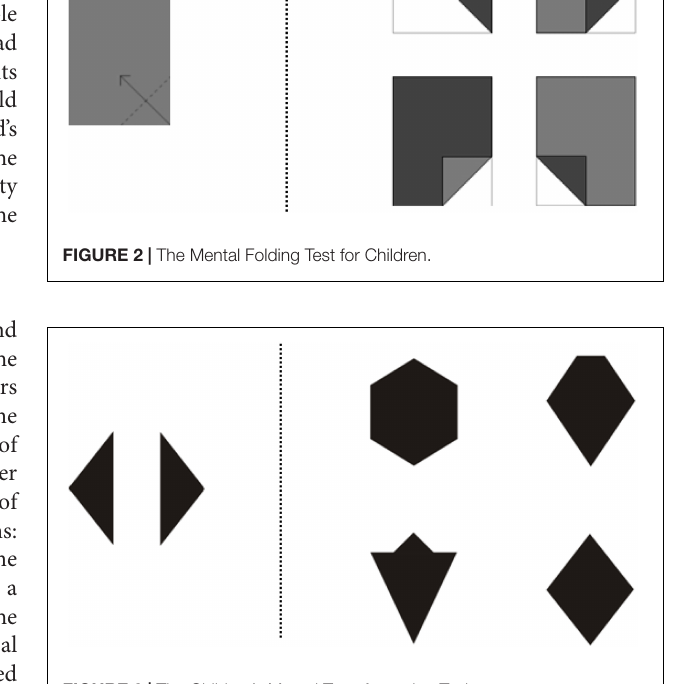
FIGURE 3 | The Children’s Mental Transformation